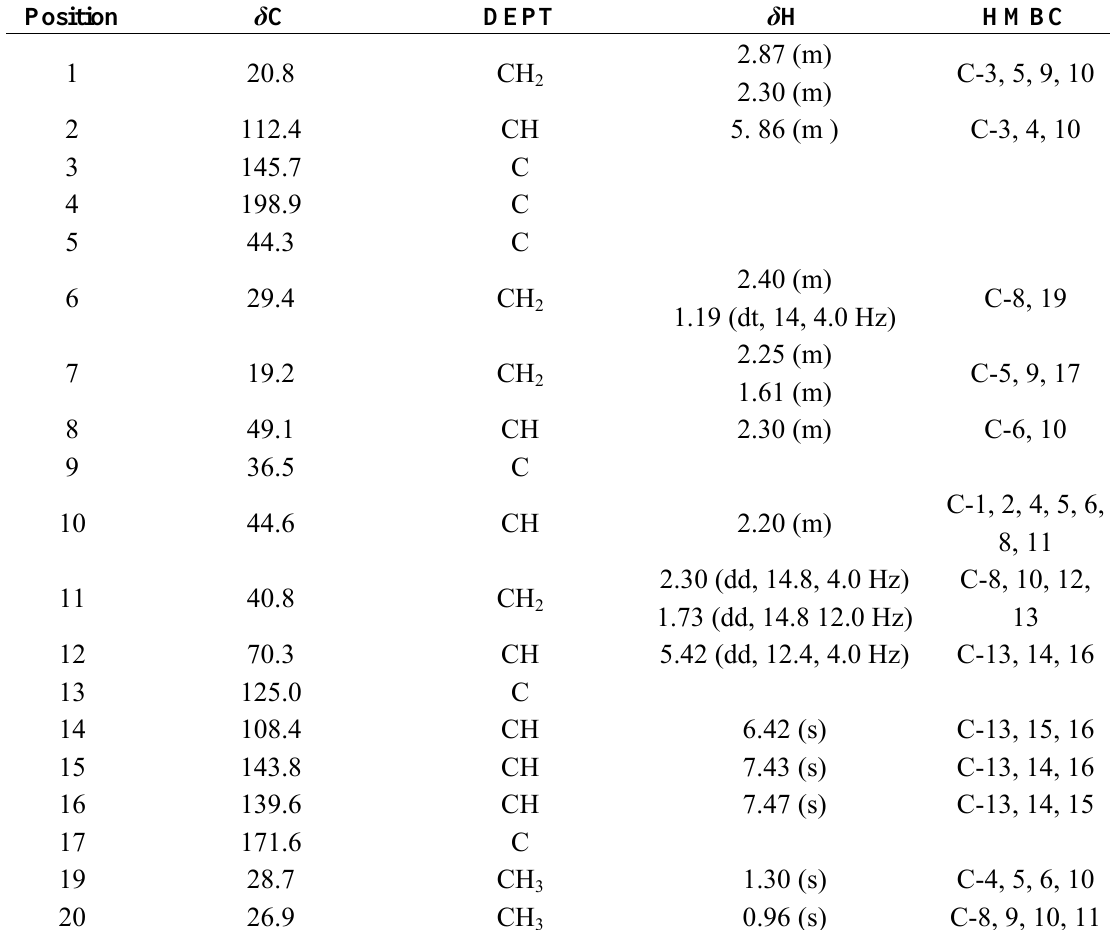
. ( 1 H at 400 and 13 C at 100 MHz; J in 3